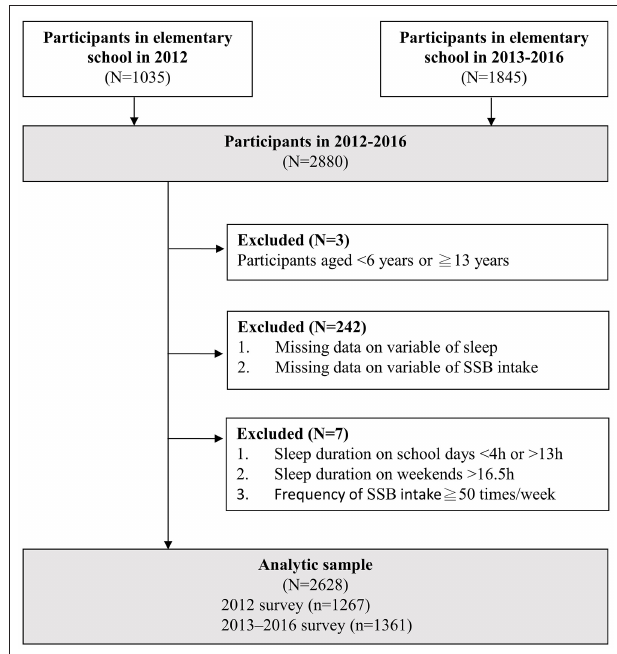
FIGURE 1 | Flowchart of the study participants.